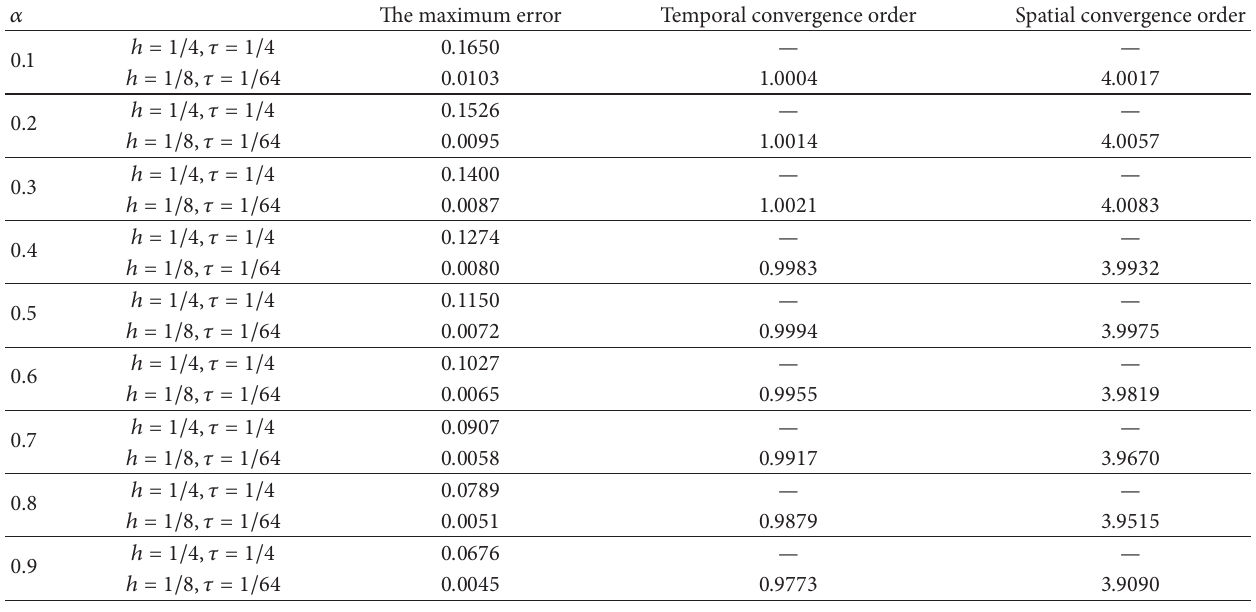
Table 1: The maximum error, temporal, and spatial convergence orders by difference scheme (14) for different 𝛼